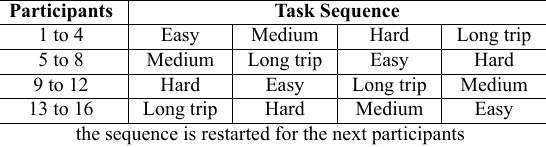
Table 2. Latin Square Model for participants and